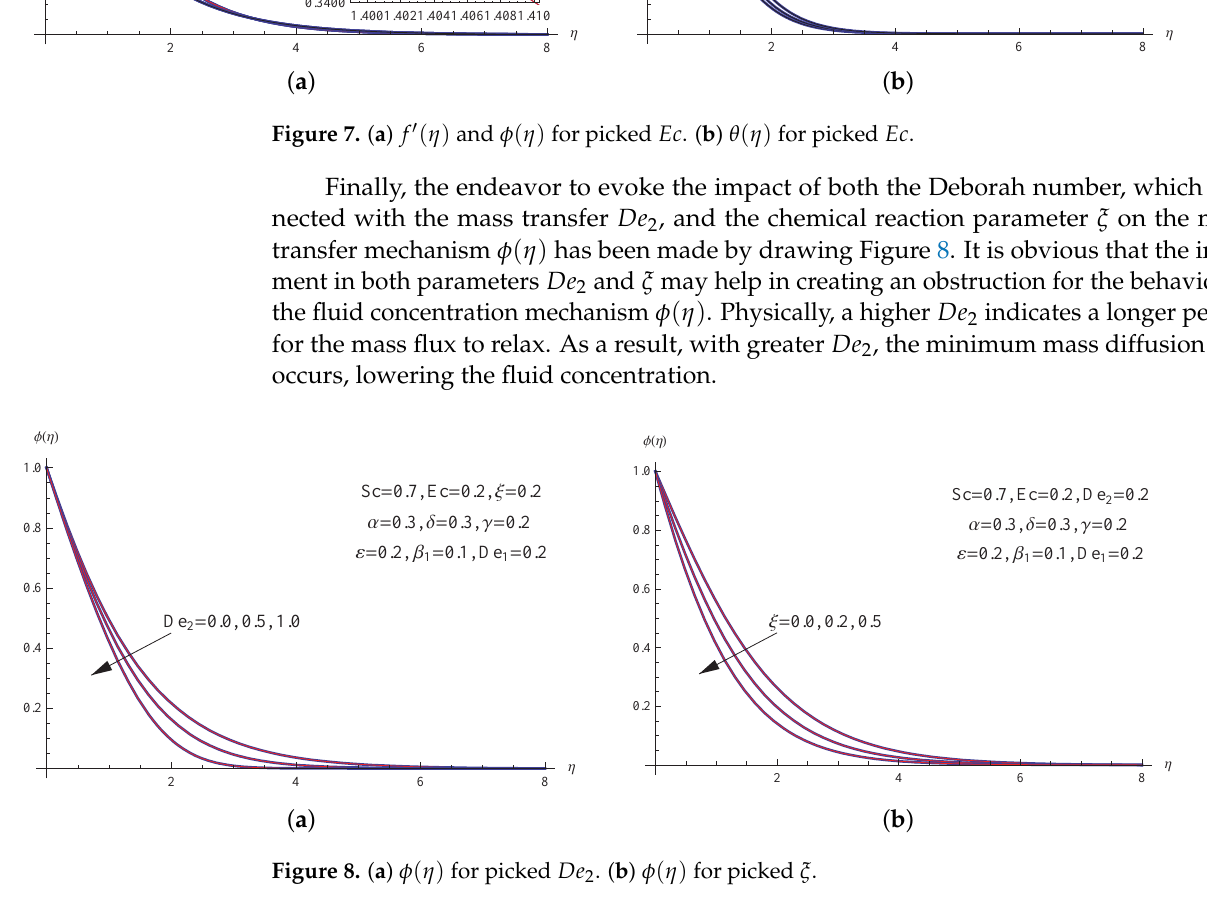
1.140 1.145 1.150 1.155 1.160